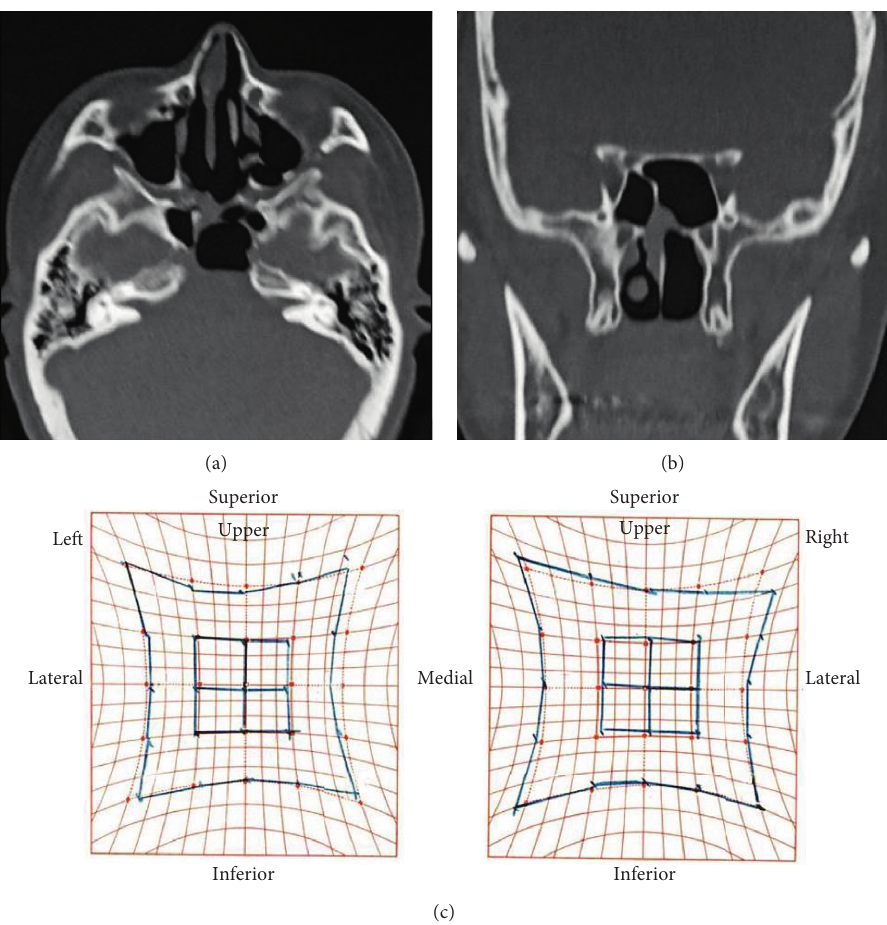
Figure 6: Postoperative evaluations. (a), (b) Postoperative computed tomography (plain) imaging of the paranasal cavity with a diminished sphenoid sinus mucocele, and (c) Hess screen test showing improvement in the abduction